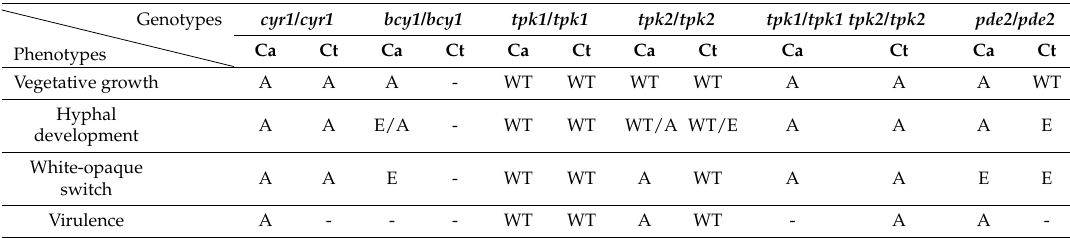
Table 1. Conserved and divergent functions of the cAMP/PKA signaling pathway in C. albicans and C. tropicalis